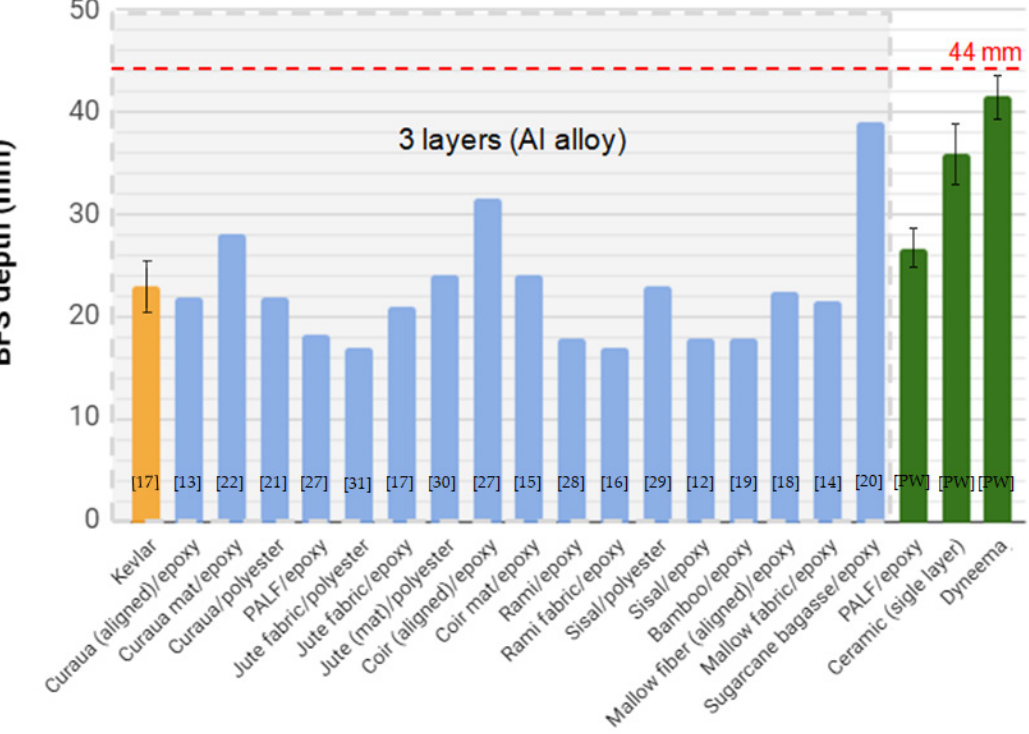
Figure Figure 4. Comparative graph showing multilayered armor systems (MASs) with three layers (ceramic